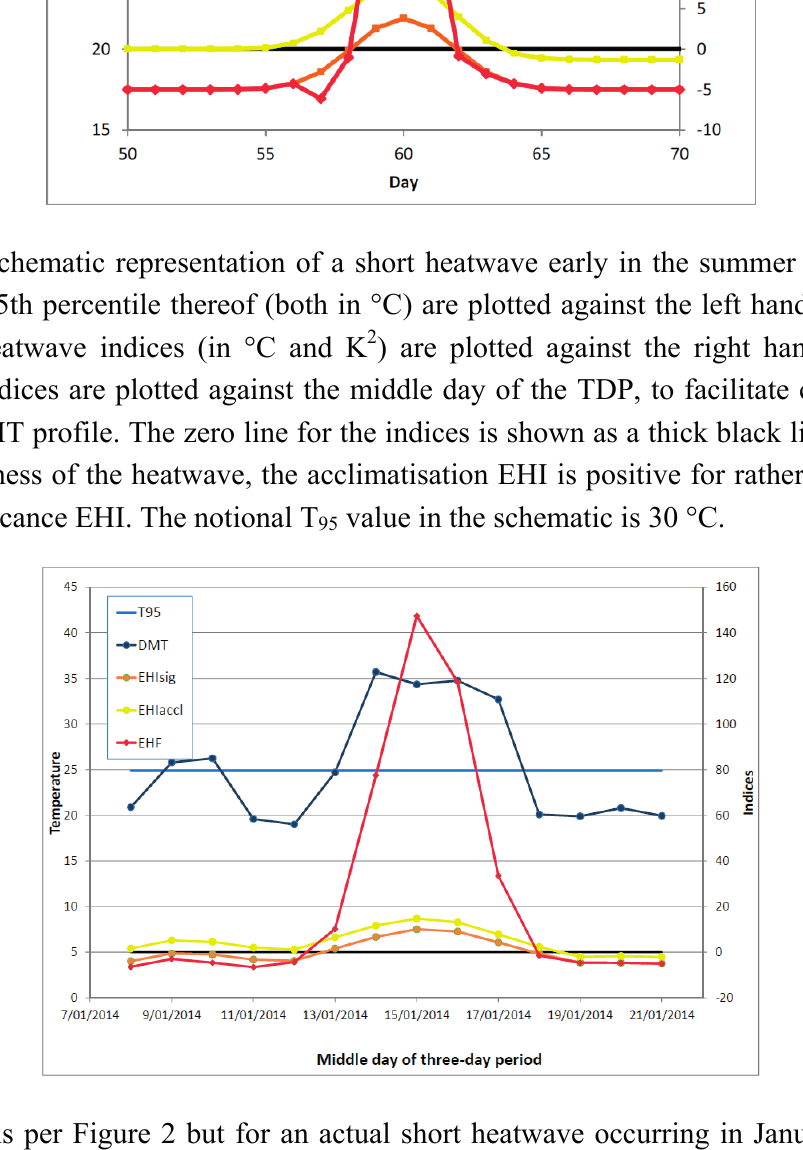
Figure 3. As per Figure 2 but for an actual short heatwave occurring in January 2014 in Melbourne, Australia. Data from the Melbourne Regional Office site (Bureau of Meteorology station number 086071). The T value at this site is 24.9 95